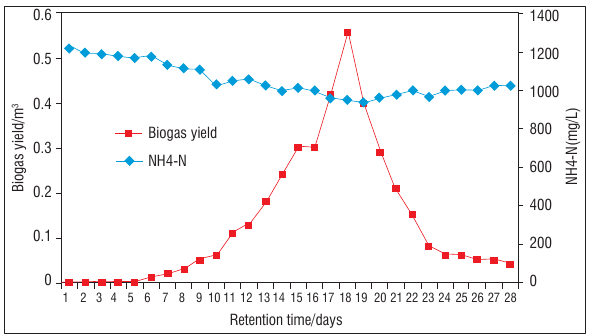
Figure 7: Relationship between biogas yield and NH4-N for donkey dung Table 4 shows the biogas composition for donkey dung. The biogas composition of donkey dung consisted of methane, carbon dioxide and hydrogen. The composition of hydrogen and other gases in the biogas was 5%, whereas the composition of carbon dioxide was 40%. In addition, the methane content in the biogas was 55%. We observed that biogas from donkey dung did not contain carbon monoxide. Biogas composition of donkey dung Gases Composition (%) Methane (CH ) 55 4 Carbon dioxide (CO ) 40 2 Carbon monoxide (CO) 0 Hydrogen (H ) and other gases 2